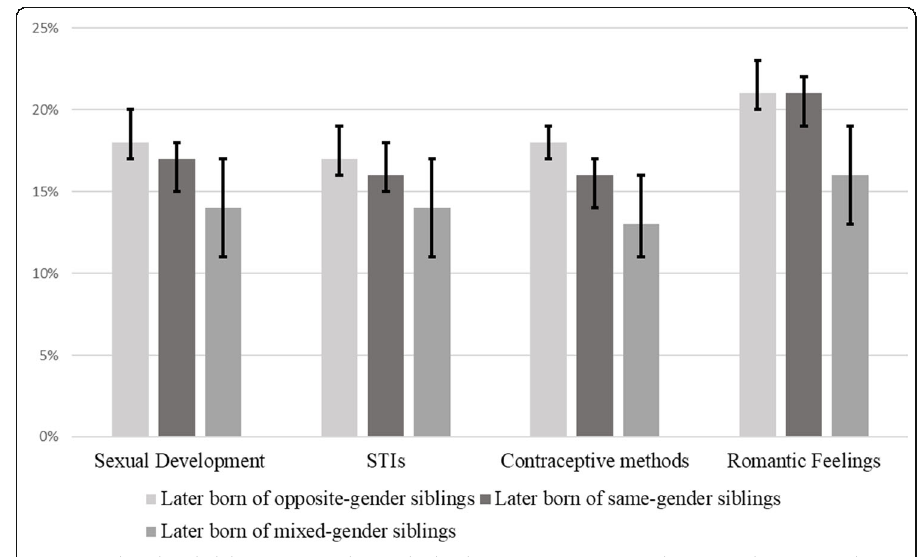
Fig. 3 Predicted probabilities to report having had a deep communication with parents about sex and romantic topics by respondents ’ gender sib-ship composition. Results from logistic regression models on later-born children. Source: SELFY (2000 and 2017). Note: N = 6,213; predicted probabilities with 95% confidence